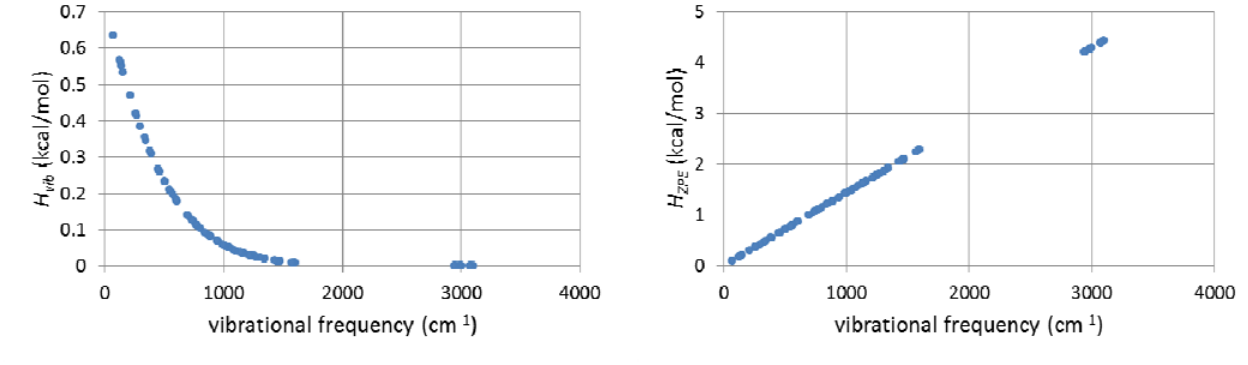
( left ) and H ( right ) terms for the unlabeled ground vib ZPE